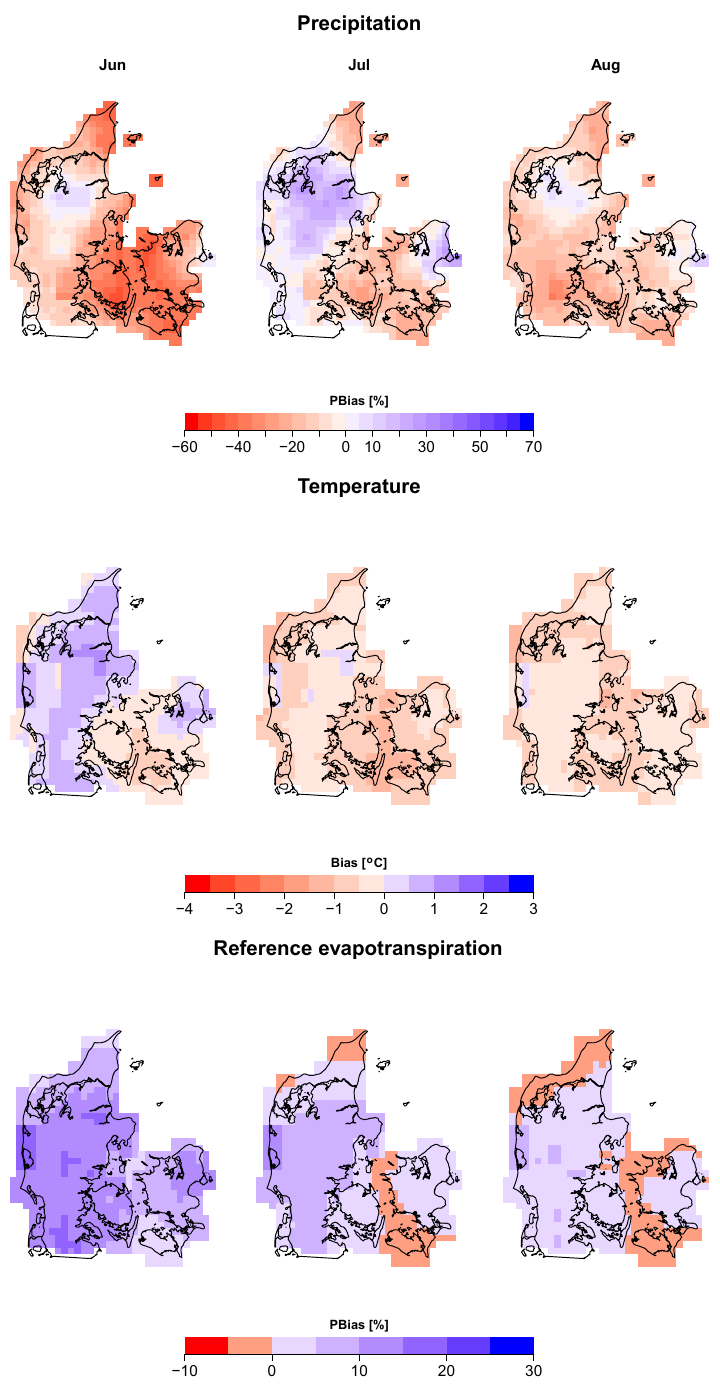
Figure 4. Percentage bias and absolute bias of monthly values of raw forecasts for the summer (JJA). Forecast lead time of 1 month.